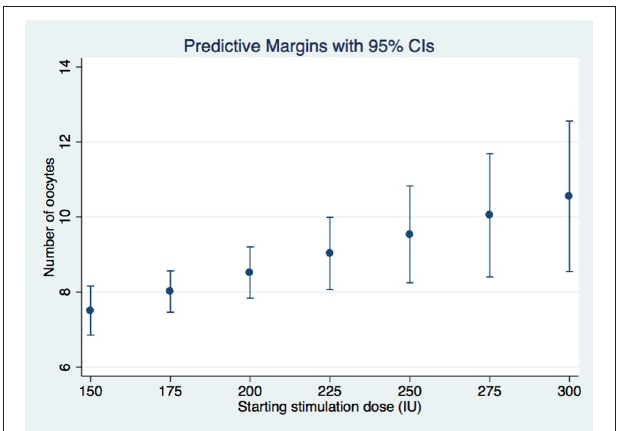
FIGURE 2 | Mean number of oocytes according to the dose of